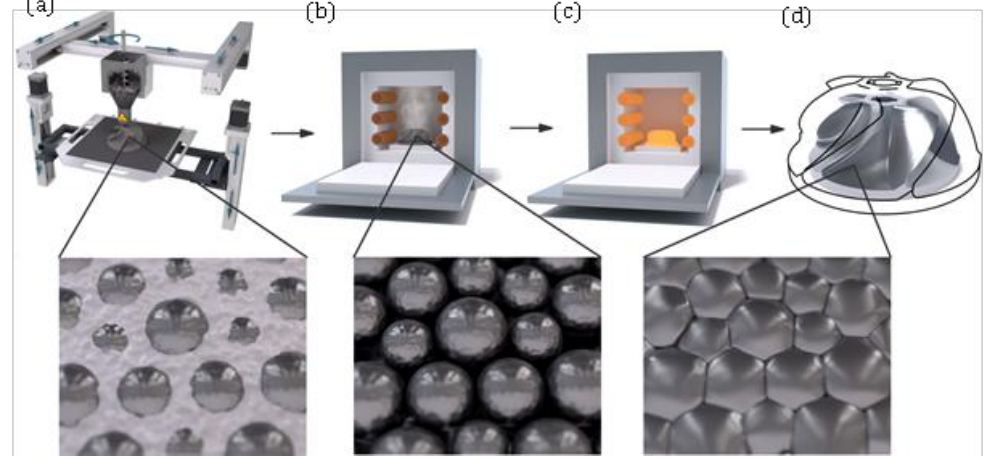
Figure 4. Process scheme of an extrusion-based system: ( a ) 3D printing of the green part ( b ) debinding of the green part in a debinding furnace; ( c ) sintering of the resulting brown part in a high-temperature furnace; ( d ) final metal part [85].